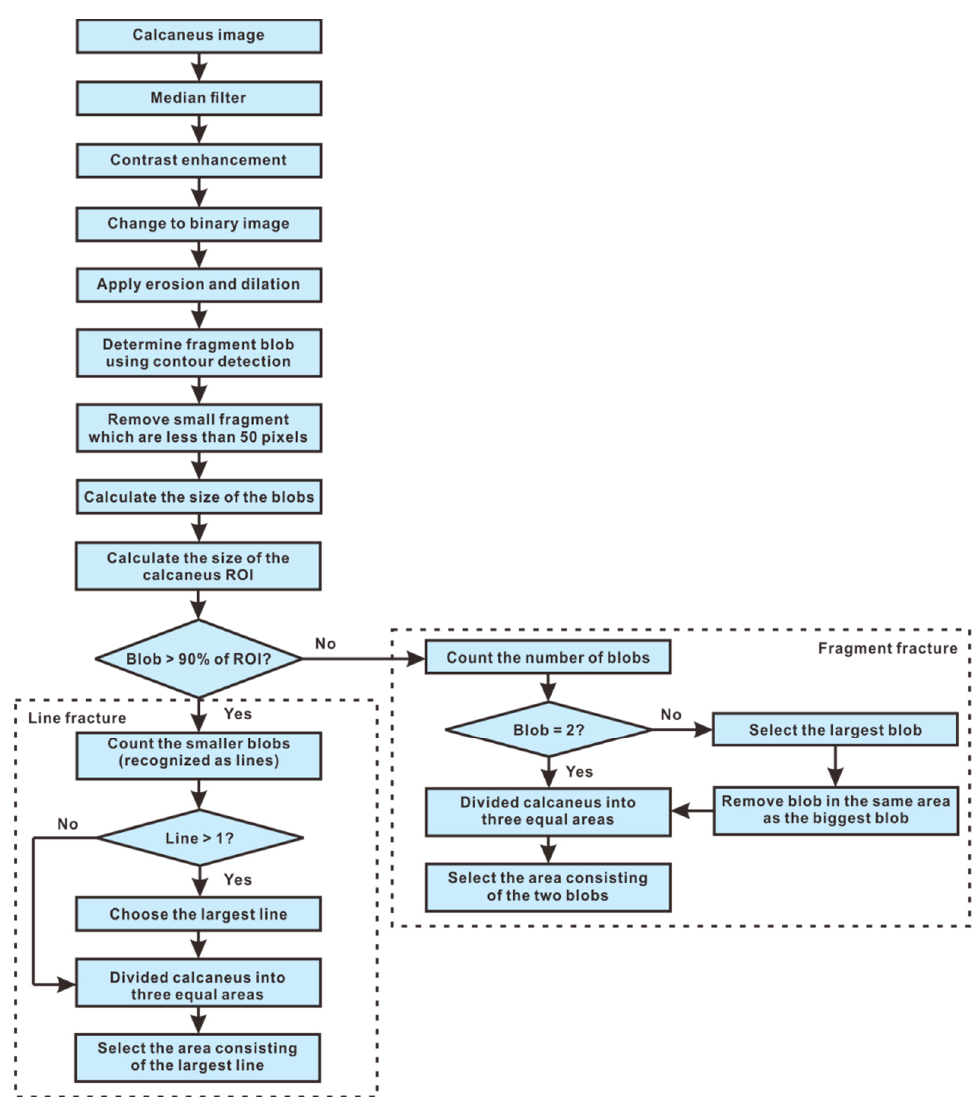
Figure 12. Algorithm for determining the type of calcaneal fracture in sagittal images.